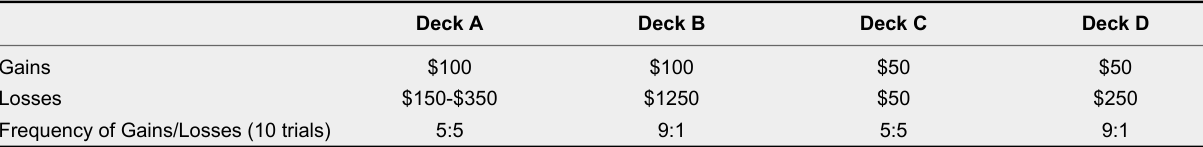
Gains and Losses on the Iowa Gambling